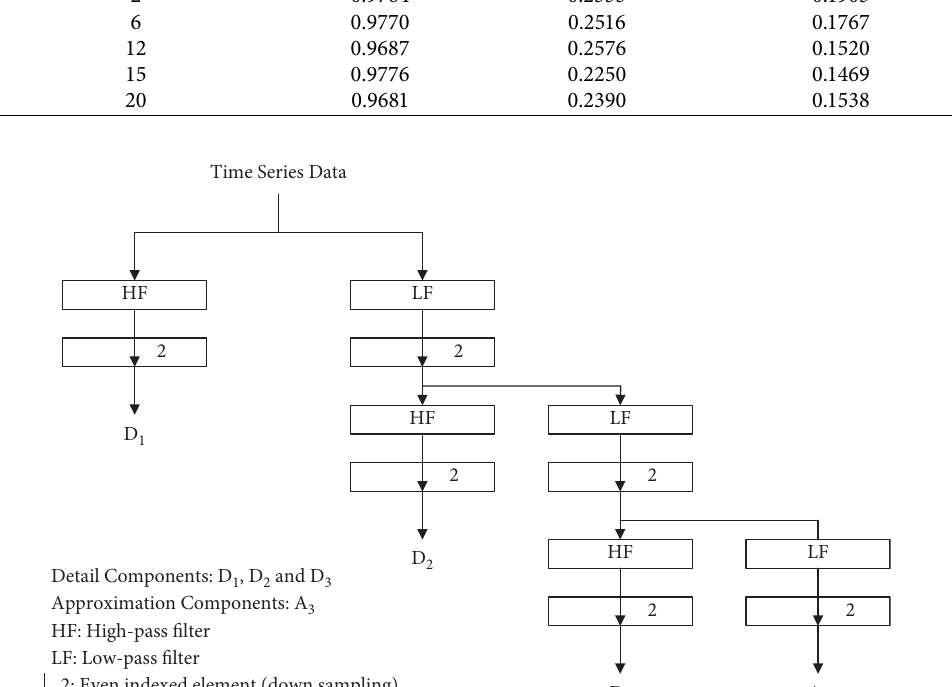
Figure 3: Shows time series data with wavelet components ( D